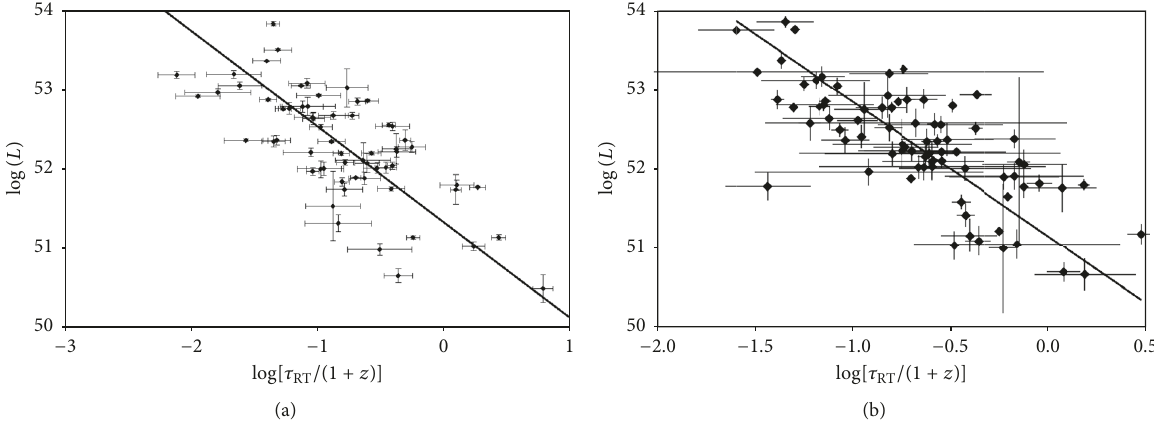
Figure 4: (a) The log 𝐿 - log 𝜏 ∗ relation with the best-fit line displayed. The errors are given by the 1𝜎 confidence interval. (Figure after iso RT Schaefer [157]; see Figure 5 therein. @ AAS. Reproduced with permission.) (b) The log 𝐿 after Xiao and Schaefer [159]; see Figure 3 therein. @ AAS. Reproduced with